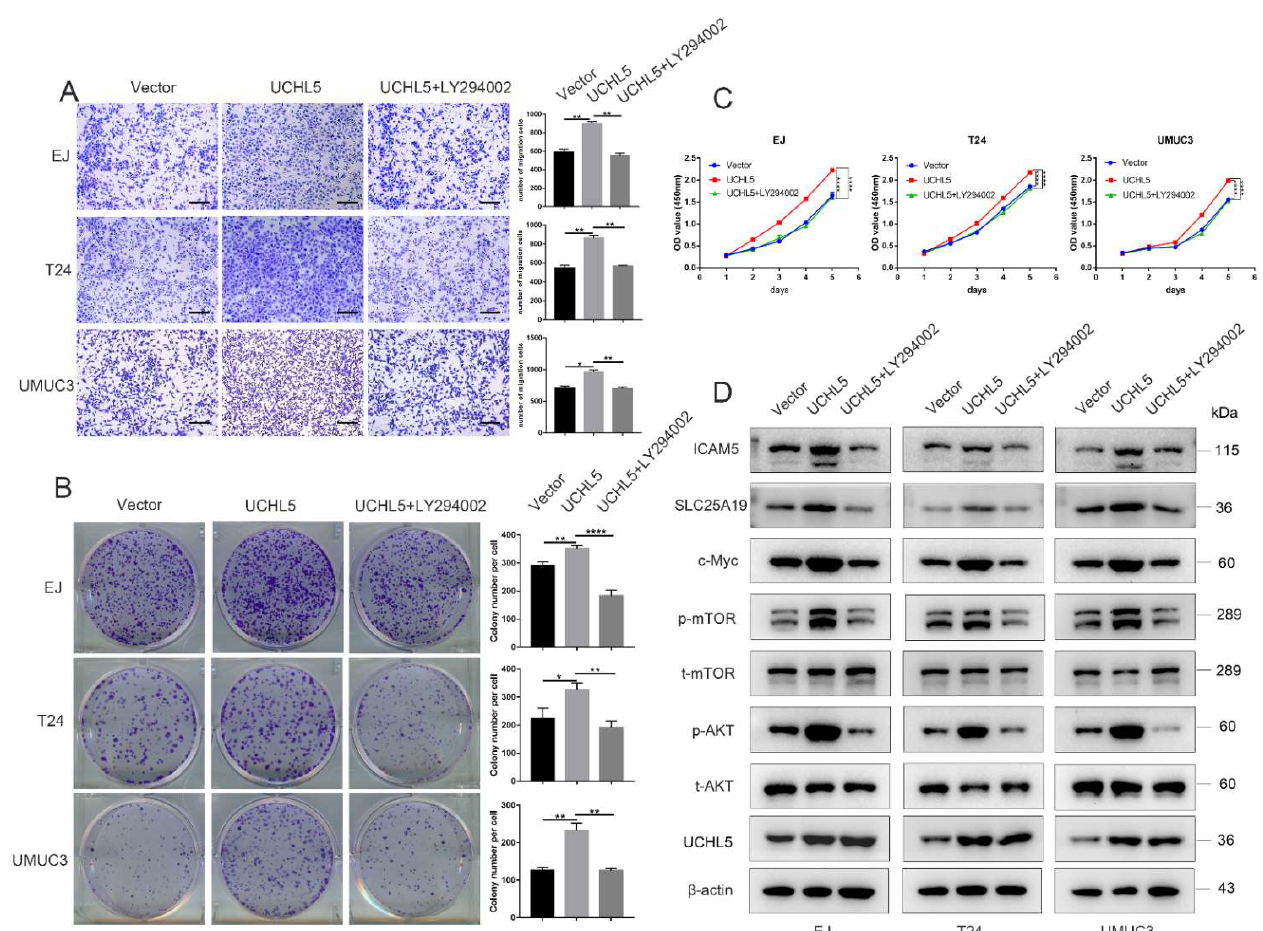
Figure 6. LY294002 rescues the effect of UCHL5 upregulation in bladder cancer cells. ( A ) Transwell assay was used to assess cell migration of Vector, UCHL5, and UCHL5 + LY294002 (Scale bar = 200 µ m). ( B , C ) Cell proliferation of three groups evaluated using CCK-8 and colony formation assays. ( D ) Western blotting analysis of the UCHL5, p-AKT, t-AKT, p-mTOR, t-mTOR, c-Myc, SLC25A19, and ICAM5 protein expression in bladder cancer cells. β-Actin is used as the loading control. Values are shown as mean ± SD. * p < 0.05, ** p < 0.01, and **** p < 0.0001 compared with controls.